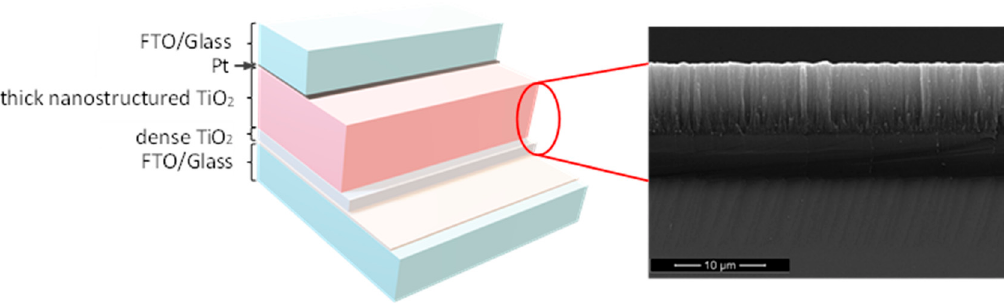
Figure 1. Schematic design of the solar cell ( left ); and cross-section SEM image of the TiO 2 coating ( right ).